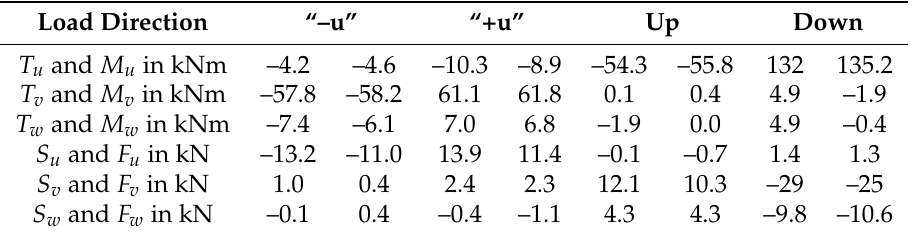
Table 1. Comparison between loads T and S applied through a fixed clamped post at its top and actions M and F on foundations calculated from sensor unit’s